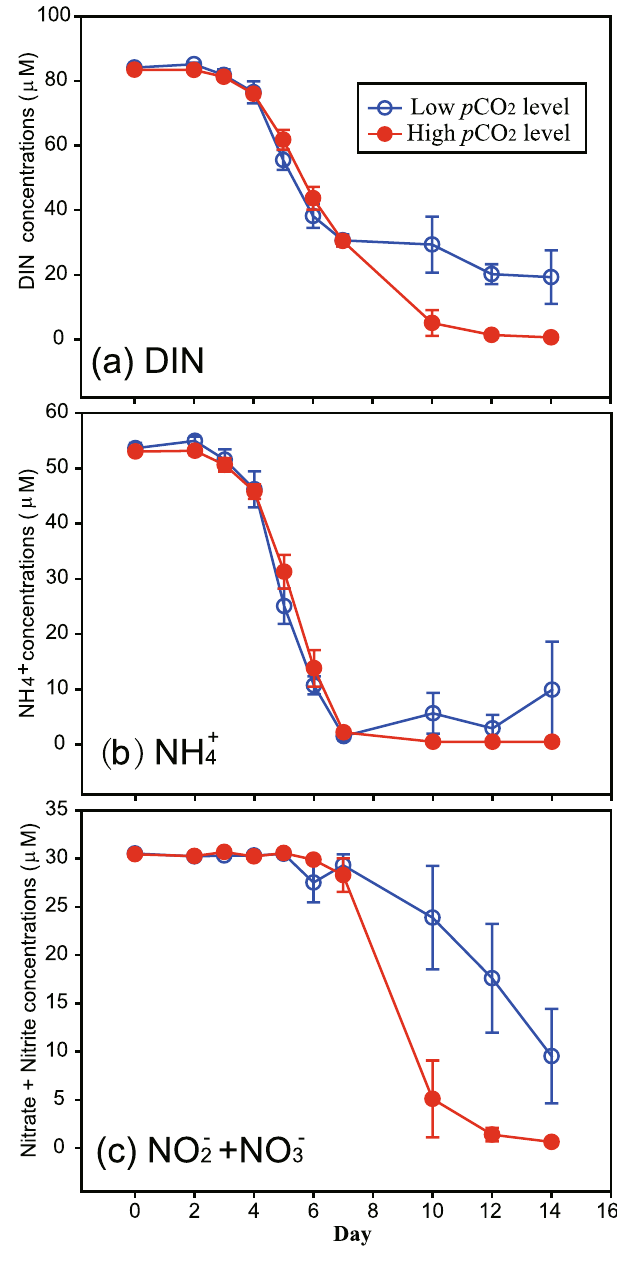
Figure 3. Temporal variations of concentrations of total dissolved inorganic nitrogen (DIN, panel a), NH 4 + ( b ) and Nitrite + Nitrate ( c ) in 6 enclosures which were perturbed by bubbling with ambient air (400 ppmv CO 2 , Low CO 2 level) or an air/CO 2 mixture at a concentration of 1000 ppmv CO 2 (High CO 2 level). Symbols are the means and error bars are the standard errors of three replicate